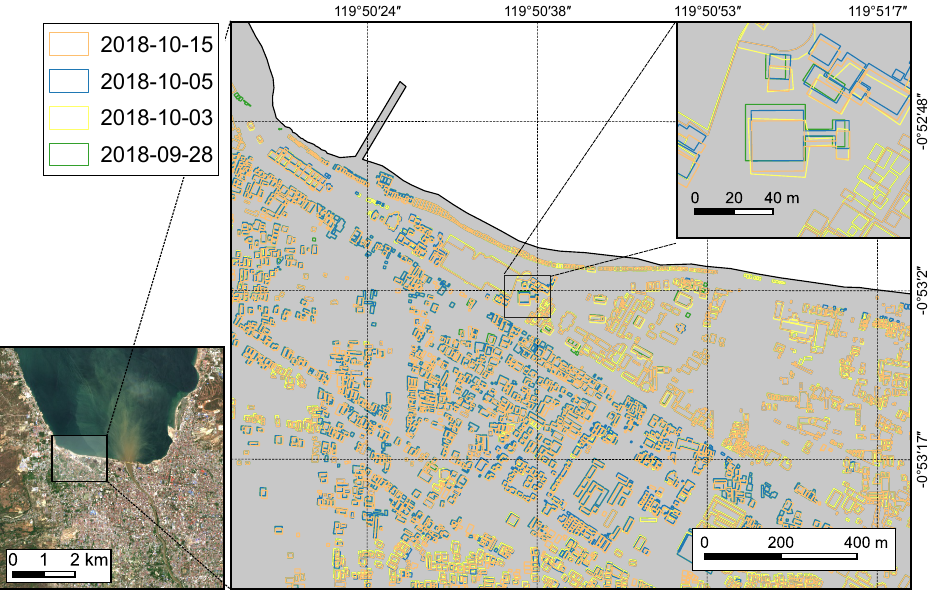
Figure 2. Examples of the OSM building layer in the days after the event. In the reference map, lower-left corner, the background corresponds to the pre-event Sentinel-2 image.